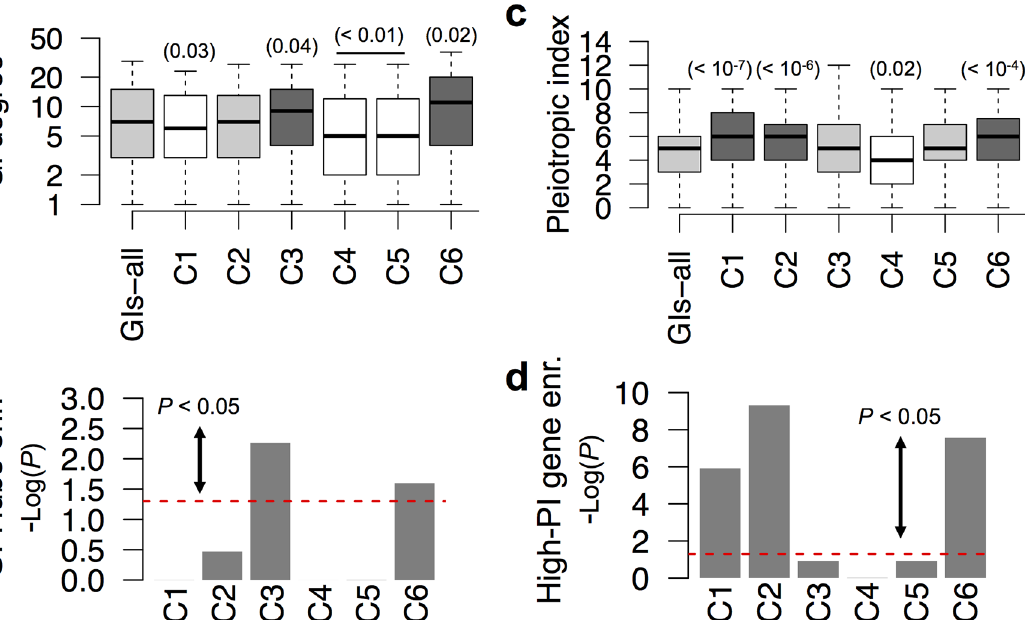
Fig 7. Defining pleiotropic and non-pleiotropic connectors. (a) Box plots showing distributions of genetic interaction (GI) degrees for GIs-all and the six classes of GIs. Distributions were found to be significantly higher (Dark grey boxes) or lower (white boxes) than GIs-all ( P < 0.05, Wilcoxon rank-sum test). Light grey boxes indicate classes with GI degree not significantly different than GIs-all. (b) Enrichment in GI-Hubs (defined as the 20% most connected genes in GIs-all) for GI classes when compared to GIs-all. (c) Distribution of pleiotropic indices (PIs) for GIs-all and the six classes of GIs. Dark grey, white and light grey boxes are designated as in panel (a). (d) Enrichment in High-PI (defined as the top 20% of genes with the highest PIs genome-wide) for GI classes when compared to GIs-all. The box plots (a, c) represent the min, max, 25 th , 50 th (median) and 75 th percentile of either GI Degree (a) or pleiotropic indices (c). (b, d) -Log 10 of P -values obtained using Fisher ’ s tests are indicated. The area over the red dashed line indicates significant enrichment ( P < 0.05).